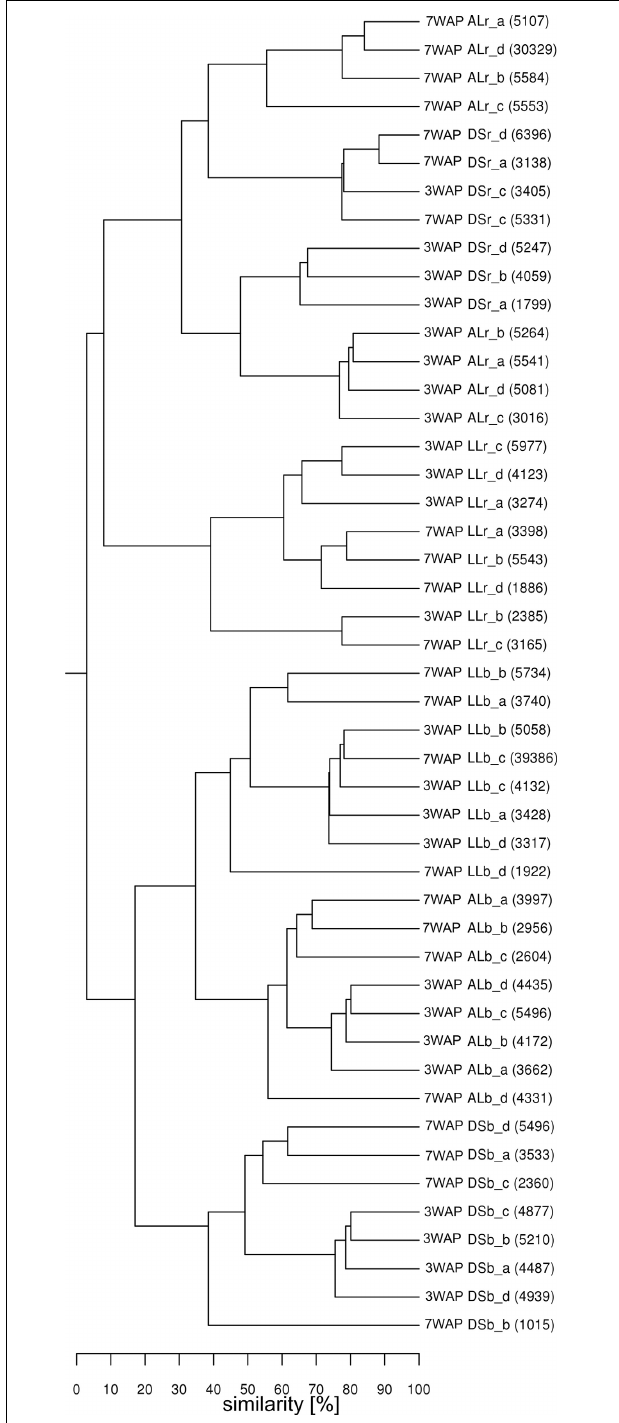
FIGURE 1 | Cluster analysis of bacterial communities from rhizosphere and bulk soil samples. Samples from rhizosphere of lettuce and the corresponding bulk soil of DS, AL, and LL soil were taken at 3 and 7 weeks after planting (3WAP, 7WAP). Similarities between samples were calculated as the Pearson correlation of the relative abundance of OTUs based on pyrosequencing data. Numbers in brackets indicate the number of sequences for the sample; r: rhizosphere samples; b: bulk soil samples; a–d: replicates.